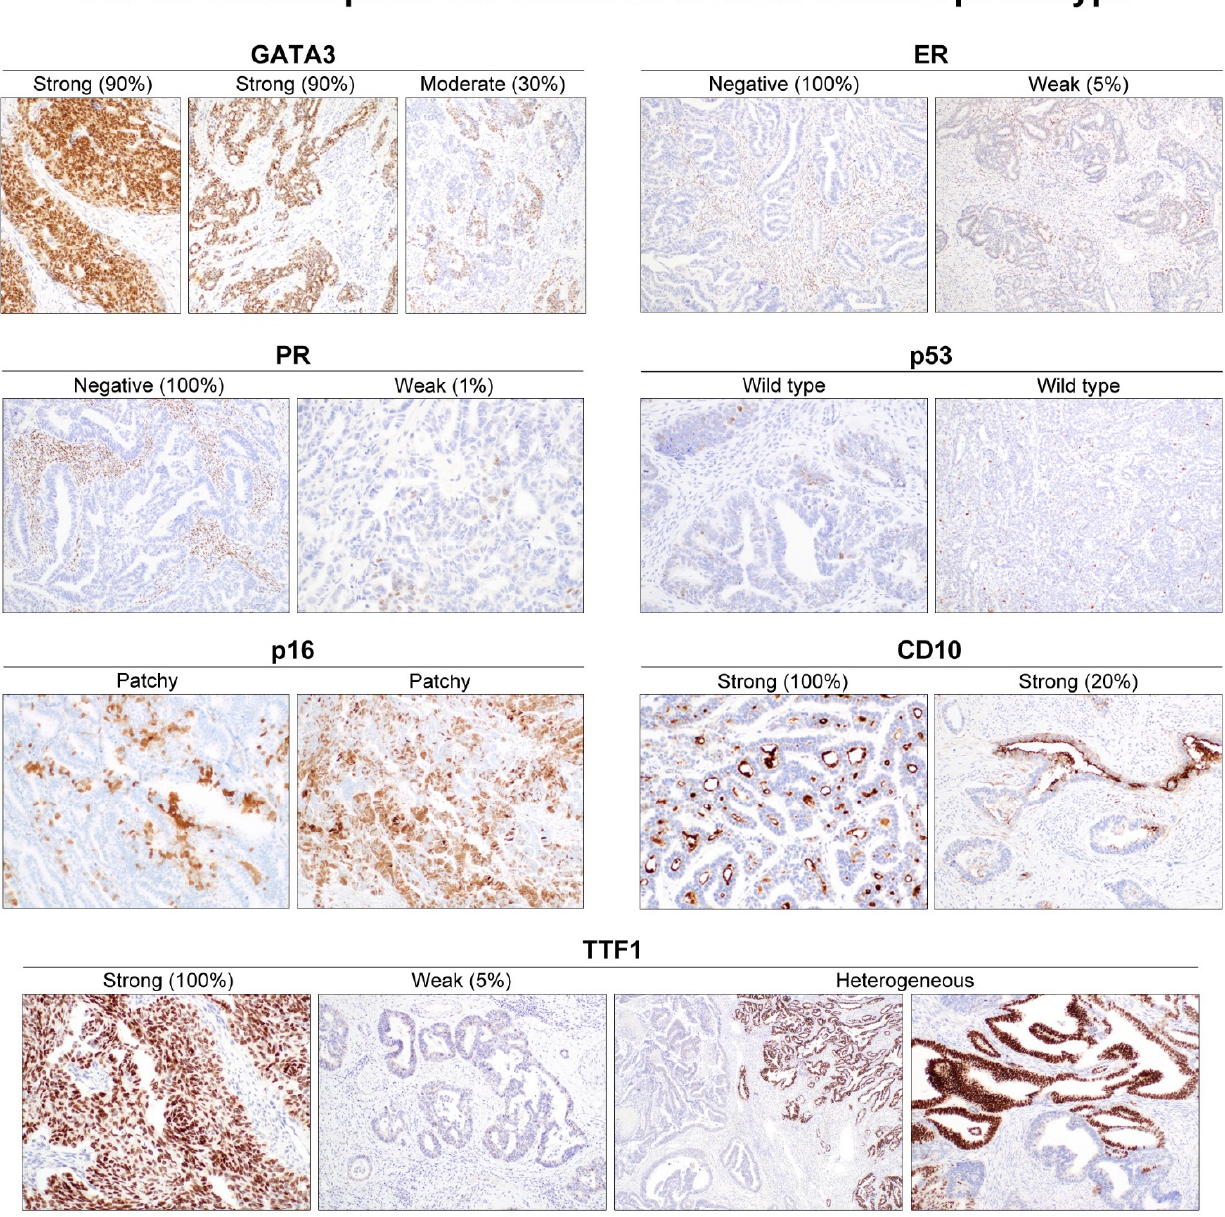
Figure 3. Typical immunophenotype of uterine MLA. In this study, more than two-thirds of uterine MLAs (17/25; 68.0%) were moderately-to-strongly positive for GATA-binding protein 3 in ≥ 25% of tumor cells. In contrast, most MLAs were negative for hormone receptors, although a few showed focal nuclear immunoreactivity for either estrogen receptor or progesterone receptor, with variable staining intensity. All tumors exhibited scattered p53-positive tumor nuclei with mild-to-moderate staining intensity (i.e., wild-type p53 IHC pattern). Most uterine MLAs demonstrated patchy p16 positivity within the nuclei and cytoplasm. The tubules and ducts showed luminal CD10 immunoreactivity with strong staining intensity. The proportion and intensity of TTF1 staining varied. A heterogeneous pattern of TTF1 expression was observed in 12 (57.1%) of the examined cases. Variable-sized microscopic areas showing a complete lack of TTF1 staining were clearly demarcated from the surrounding ducts or tumor cell clusters that were strongly positive for TTF1.